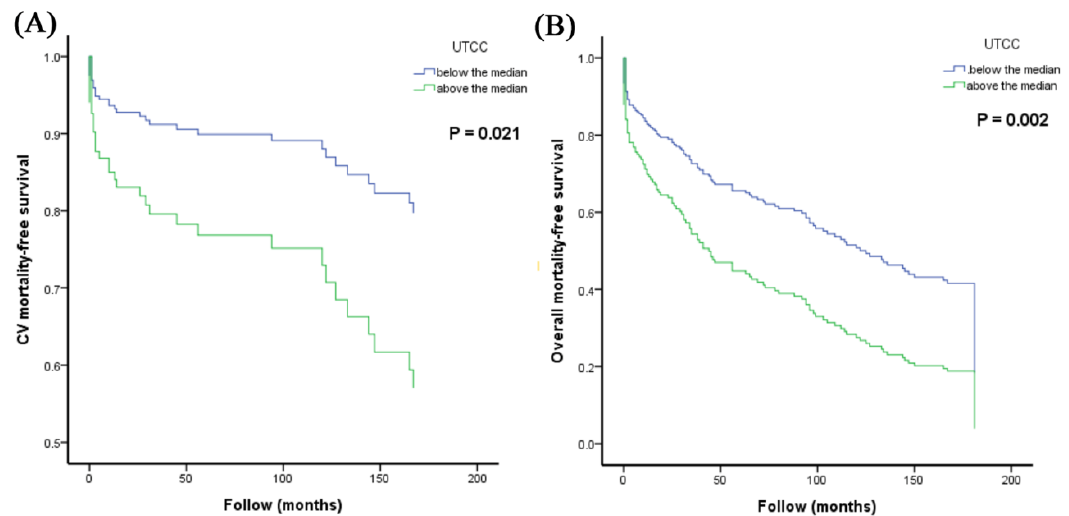
Figure 1. Adjusted Kaplan–Meier curves of UTCC above the median versus below the median for CV ( A ) and overall mortality-free survival ( B ). Abbreviation: CV, cardiovascular; UTCC, upstroke time per cardiac cycle.